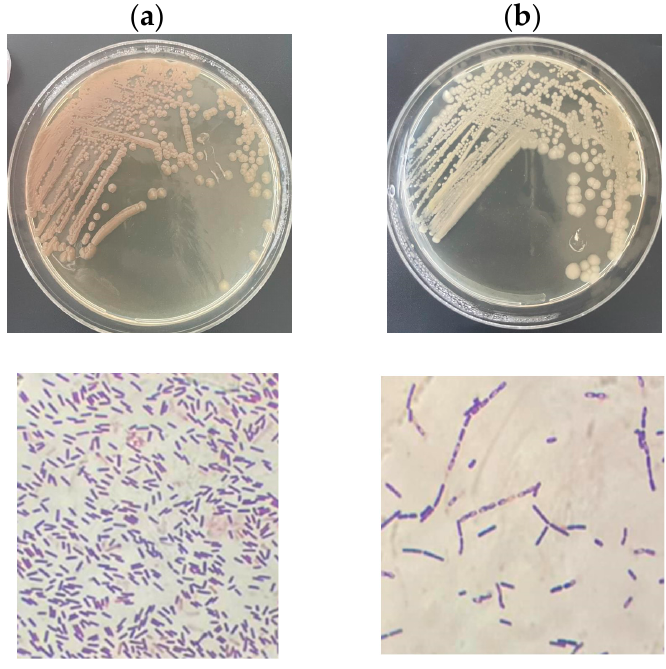
Figure 8. Identical pure cultures of the most efficient isolates on plates with nutrient agar medium and their microscopic characteristics: ( a ) A1 isolate and ( b ) A2 isolate.